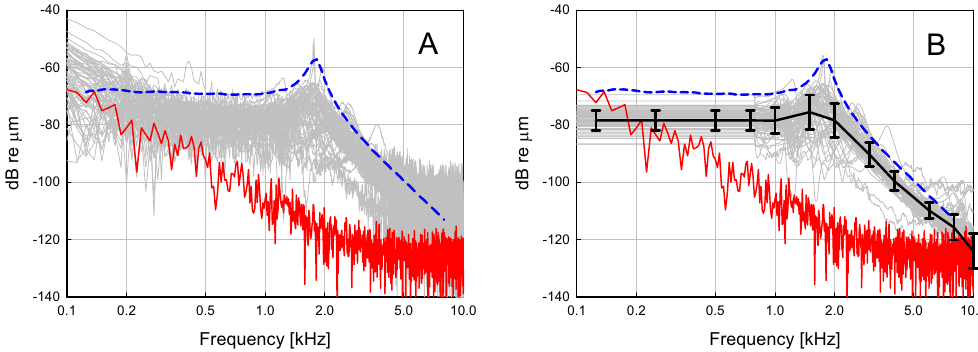
Figure 2. ( A ) Intraoperative measurement of the actuator displacement output (100 averages) when driven through a modified sound processor with pseudo-random white noise (12.5 Hz resolution 800 FFT lines) of − 46.5 dB V/line. The standard displacement output before surgery on the bench (dashed blue line) at the same input and individual displacement responses in patients (N = 66) measured intraoperatively (raw transfer function, grey). The red line depicts an example of a common noise floor level during an intraoperative measurement. ( B ) Same measurements after application of the smoothing procedure (smoothed transfer function, grey) as described in the section ‘Electro-mechanical transfer function from intraoperative measurements’ and averaged values with standard deviations